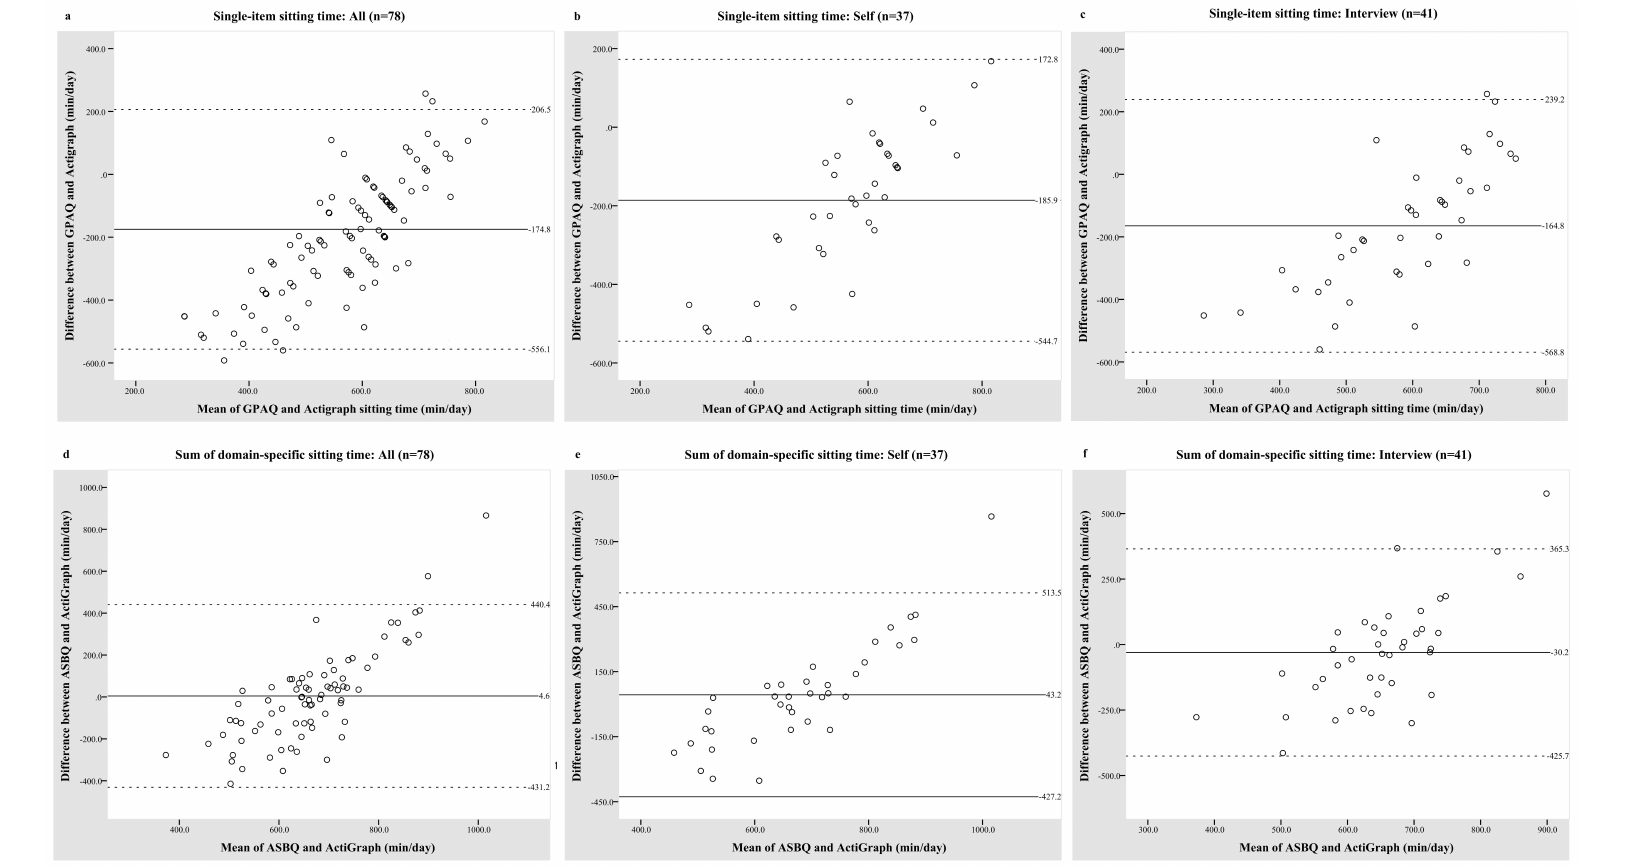
Figure 1. Bland-Altman plots of minutes of sedentary time per day between the questionnaires and ActiGraph GT3X accelerometer. ( a – c ) The Global Physical Activity Questionnaire (GPAQ) vs. accelerometry-based measures in all participants, self- and interviewer-administered groups, respectively; ( d – f ) the Adult Sedentary Behaviour Questionnaire (ASBQ) vs. accelerometry-based measures in all participants, self- and interviewer-administered groups,